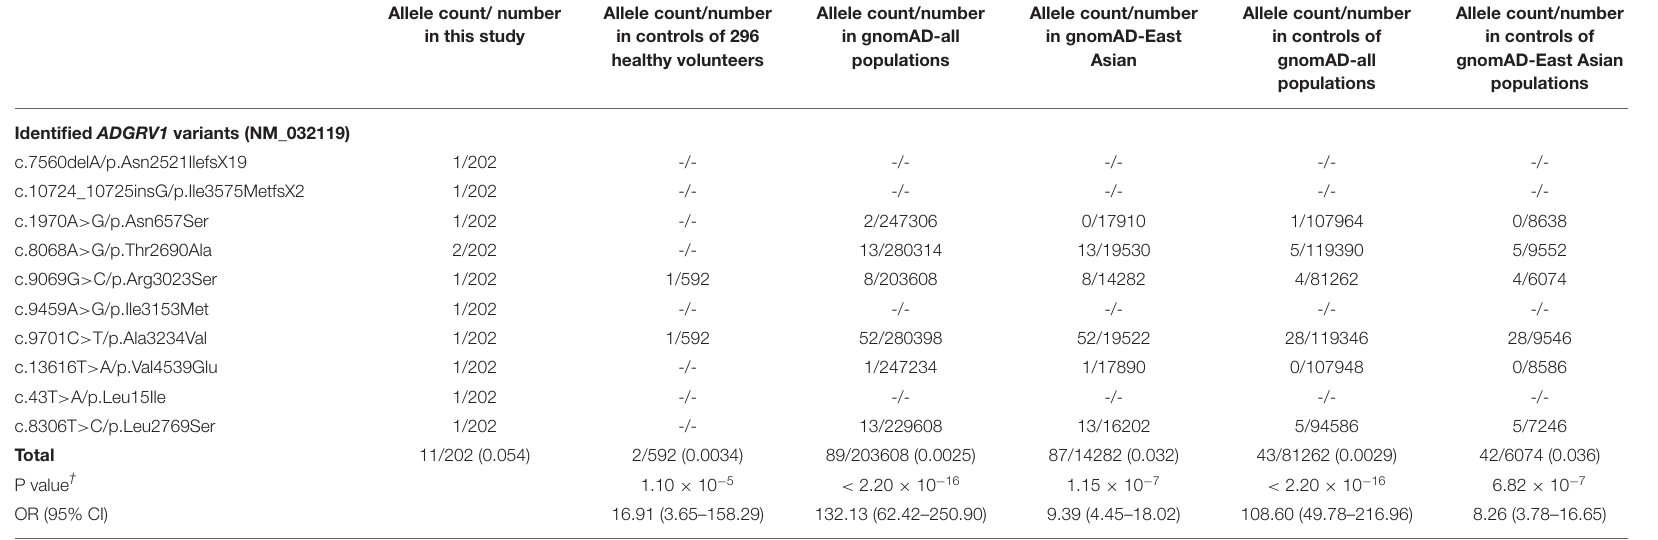
TABLE 2 | Analysis of the aggregate frequency of ADGRV1 variants identified in this study.